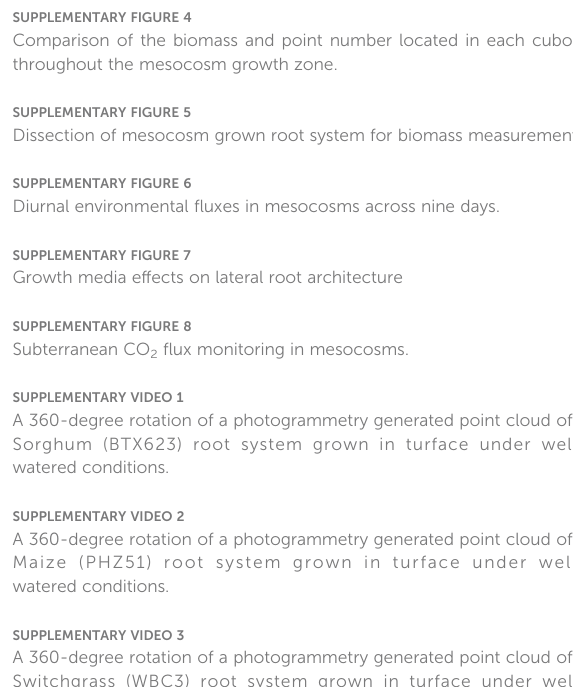
SUPPLEMENTARY FIGURE 2 Time course of shoot morphological responses of switchgrass in different growth media.